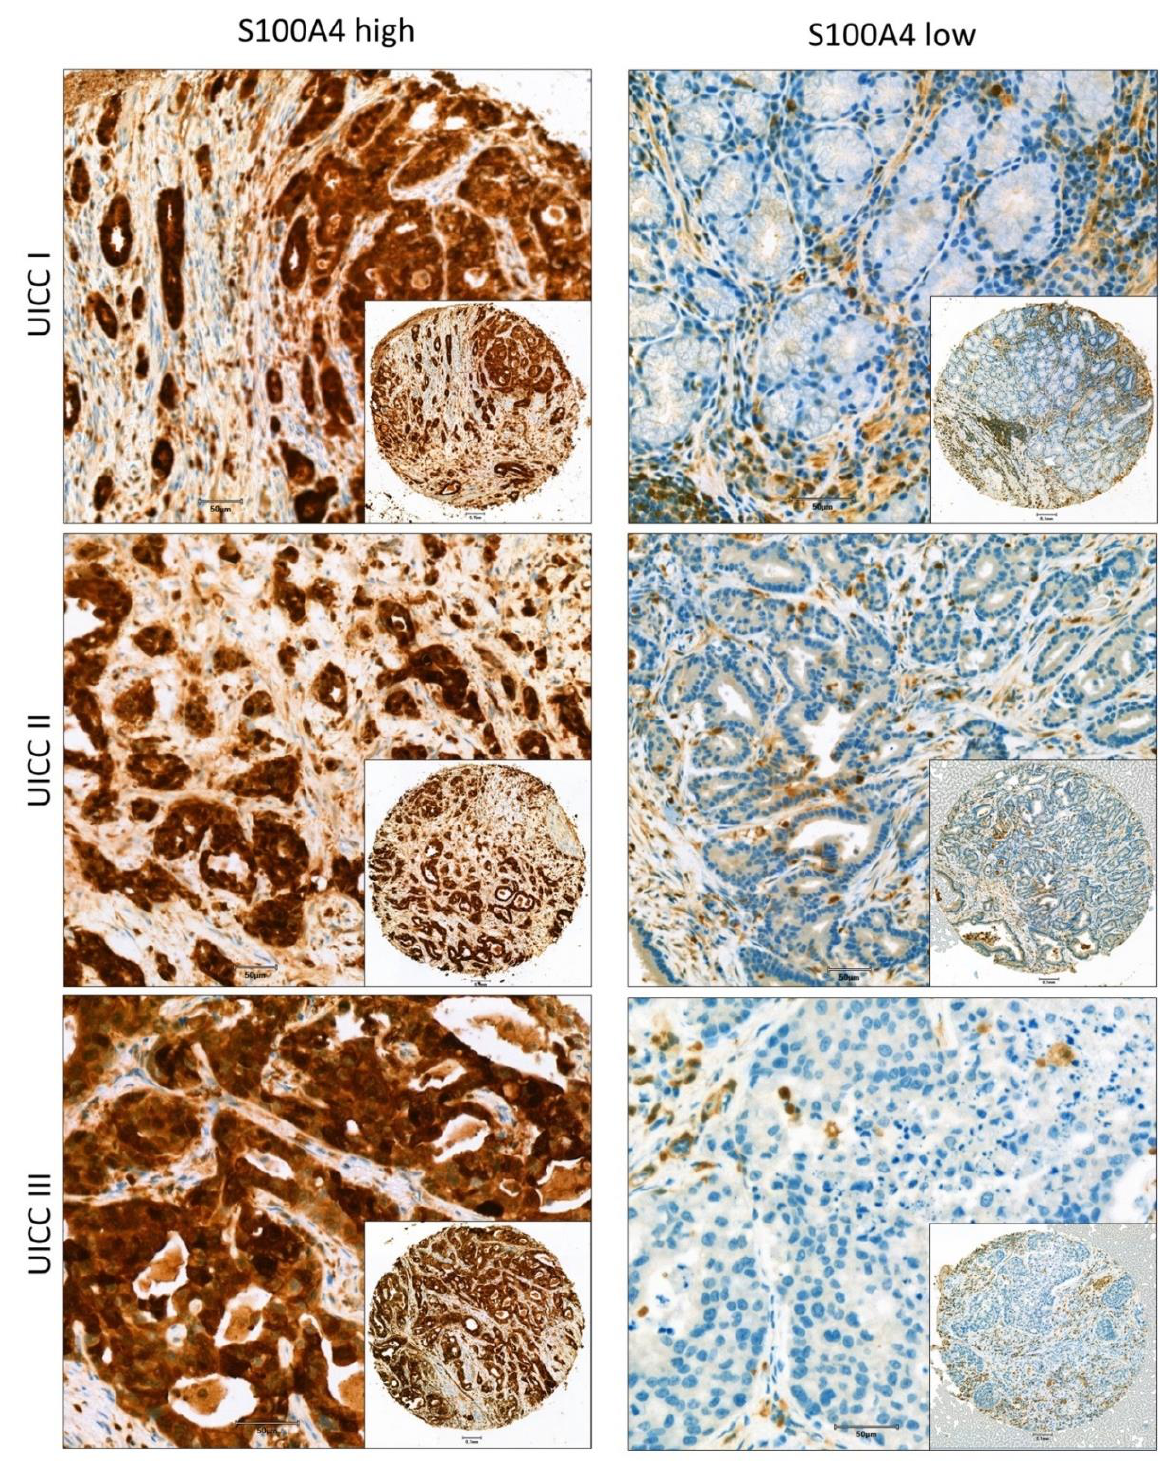
Figure 1. Representative pictures of IHC stained TMAs from the patient cohort from different tumor stages (UICC I, II and III) that were sorted either into the S100A4 high ( left ) or low ( right ) group. Scale bar 50 µm (inserts) and 100 µm (overview).